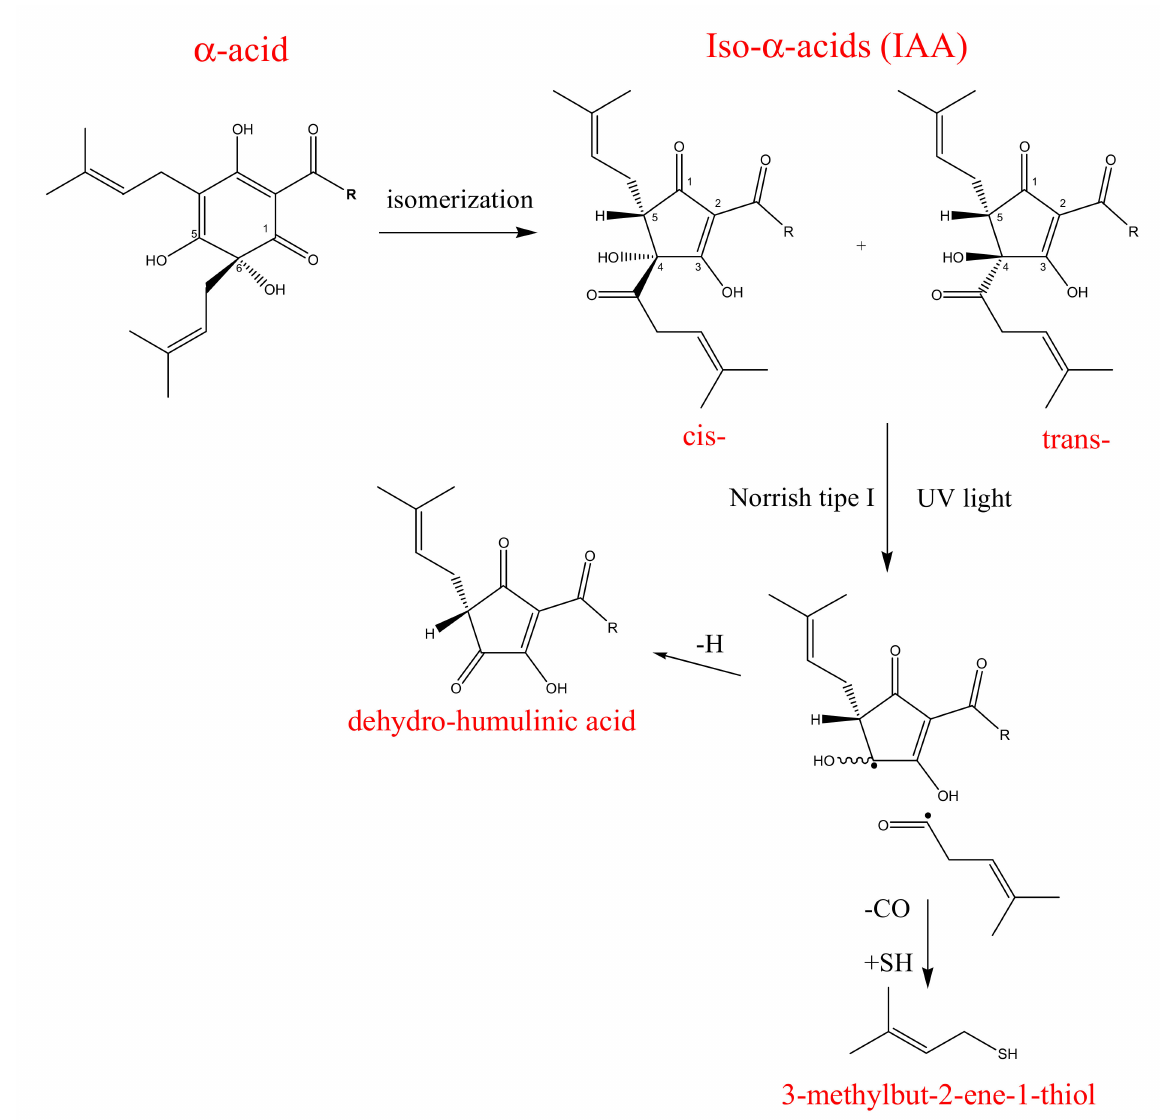
Figure 2. Isomerization of α -acids and degradation of Iso - α -acids by Norrish Type I